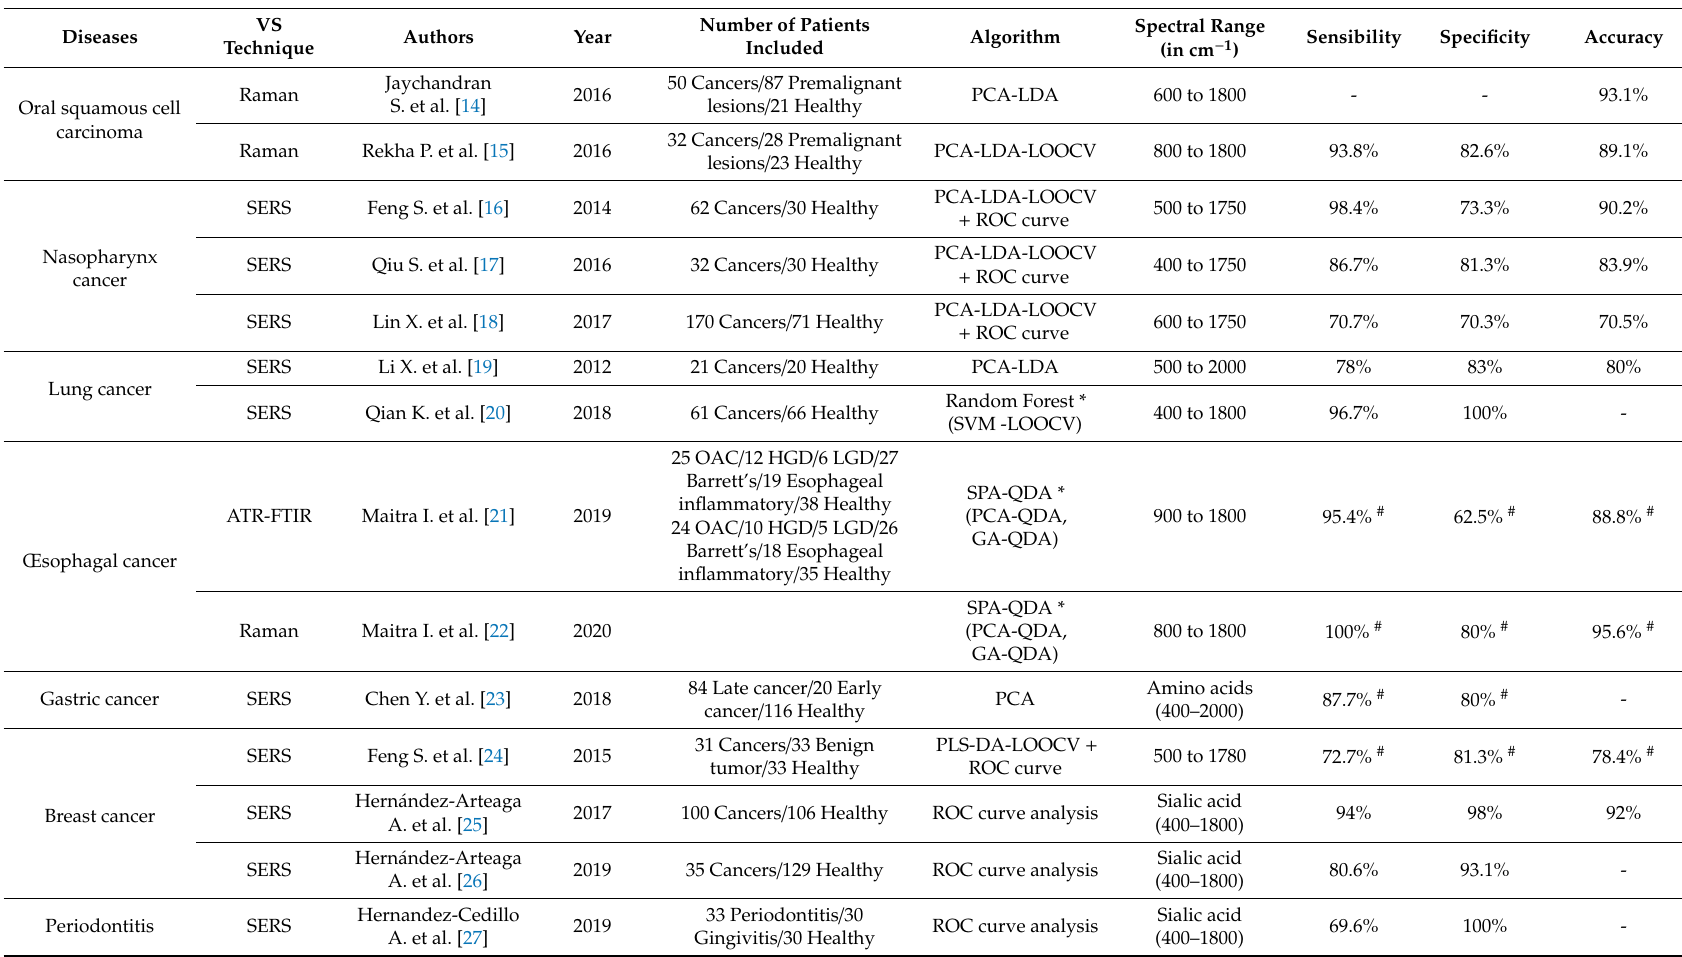
Table 1. Studies included in the systematic literature review using salivary vibrational spectroscopy as a diagnostic tool for various